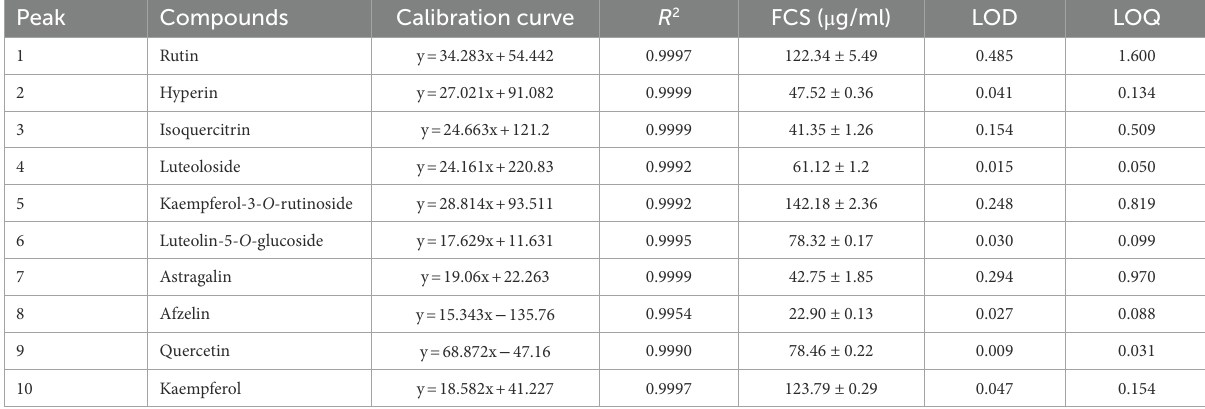
TABLE 1 Chemical composition of flavonoids from Chimonanthus salicifolius S. Y. Hu. Peak